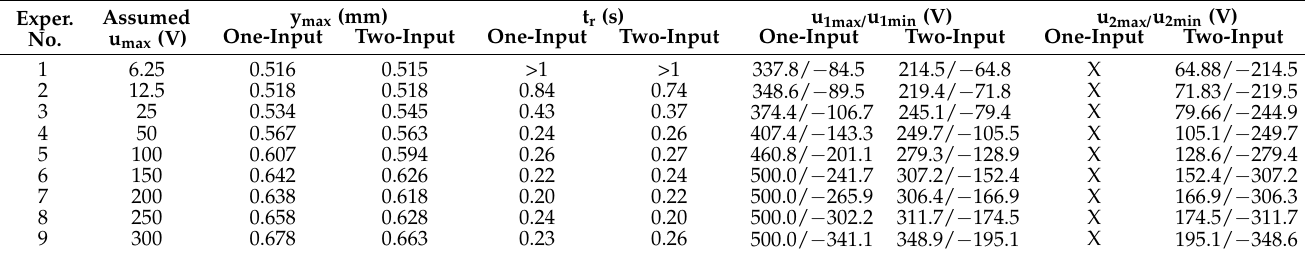
Table 3. Values of parameters in experiments.